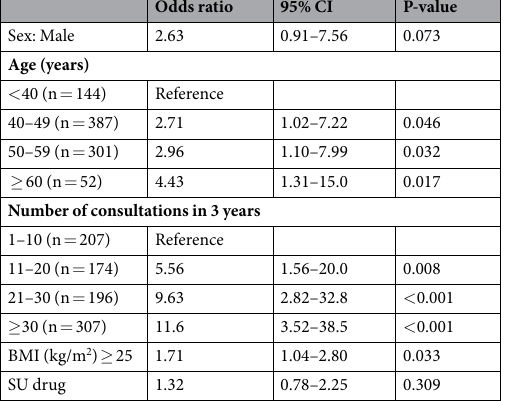
Table 2. Factors associated with polypharmacy at the end of the observation period, multiple logistic regression model. BMI, body mass index; SU, sulfonylurea.